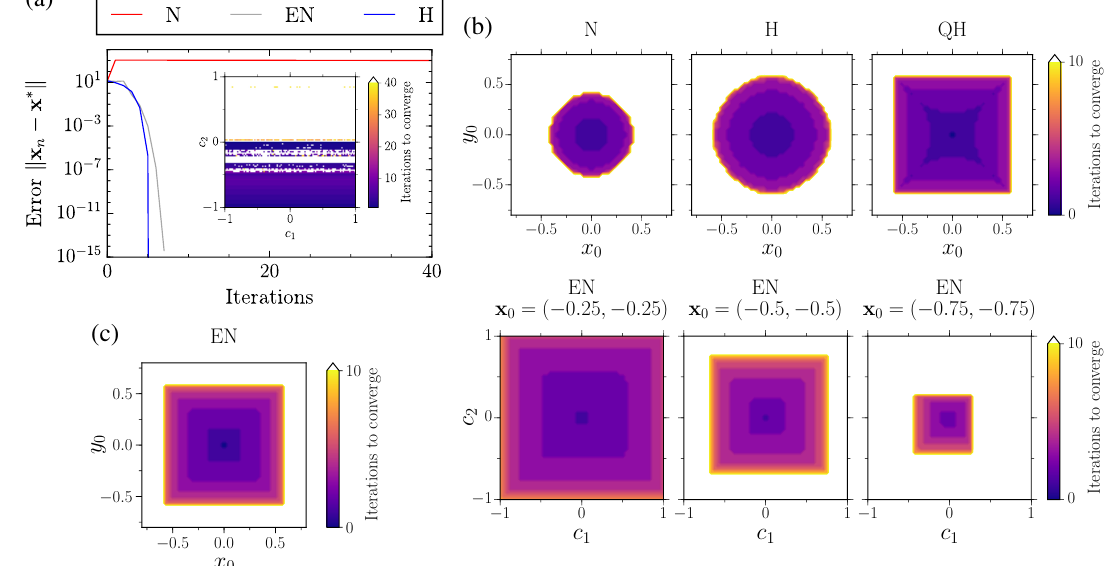
Figure 2. ( a ) Convergence for solving (18) with initial guess x 1 = x 2 = 0 using the standard Newton’s method (red line), the Extended Newton method with c 1 = c 2 = − 0.5 (gray line), and the Halley’s method (blue line). The inset shows convergence of EN with the same initial condition and varying c 1 and c 2 . ( b ) Convergence in finding the minimum of the two-variable Easom’s function by solving its derivative equal to zero (20): (top) for the standard Newton’s, Halley’s and quasi-Halley methods with varying initial conditions, and (bottom) for Extended Newton method with varying c and three initial conditions. ( c ) Convergence in finding the minimum of the two-variable Easom’s function with varying initial guesses when c i is a perturbation of initial guess, i.e., c 1 = x 0 + (cid:101) 1 and c 2 = y 0 + (cid:101) 2 , where (cid:101) 1,2 ∈ ( − 1 10 − 4 , 1 10 − 4 ) 2 2